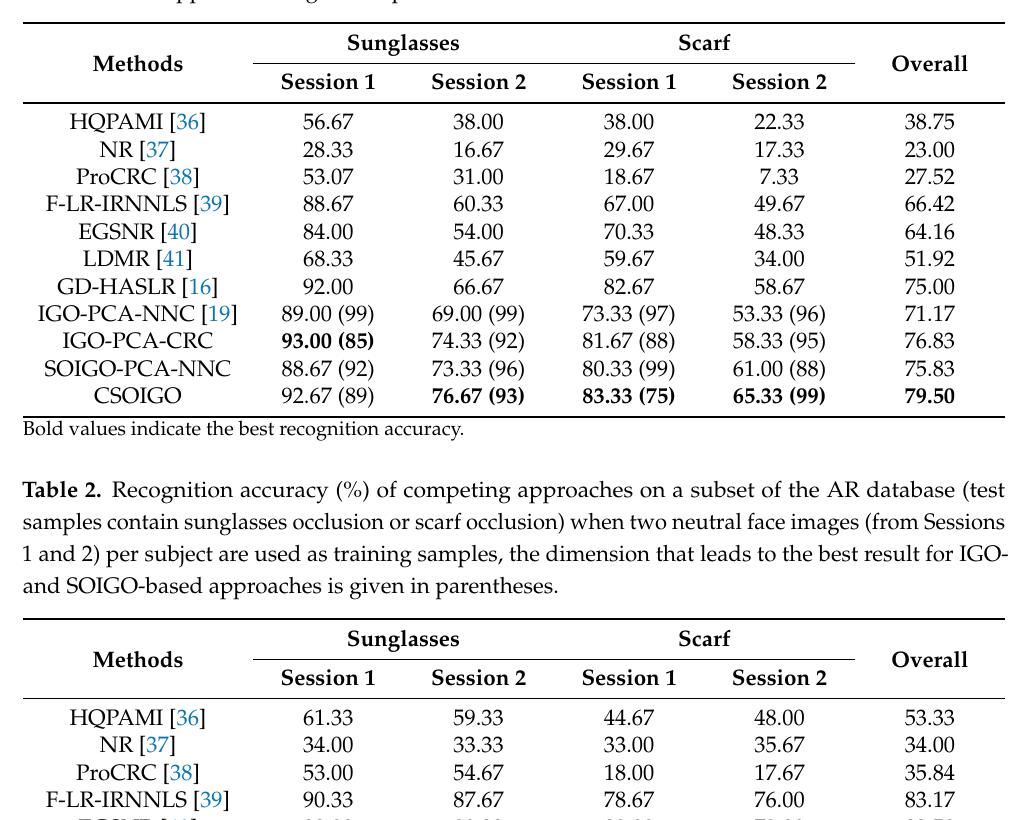
Table 1. Recognition accuracy (%) of competing approaches on a subset of the AR database (test samples contain sunglasses occlusion or scarf occlusion) when only one neutral face image per subject from Session 1 is used as training sample. The dimension that leads to the best result for IGO- and SOIGO-based approaches is given in parentheses.